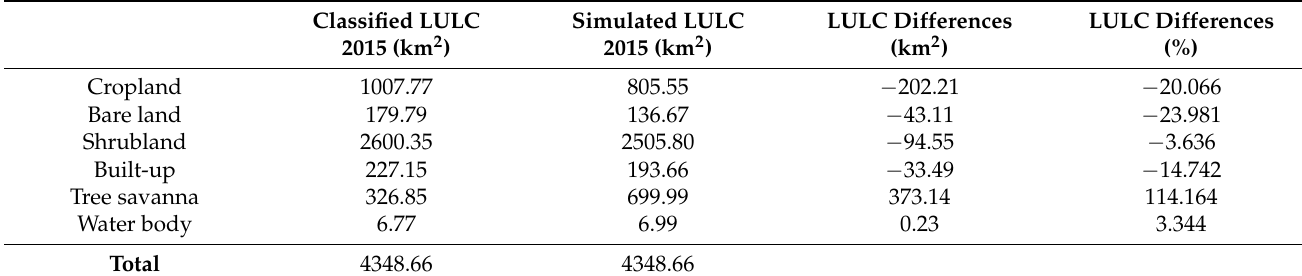
Figure 5. Classified and simulated LULC maps for 2015. Table 4. LULC change analysis between the classified and simulated LULCs for 2015.